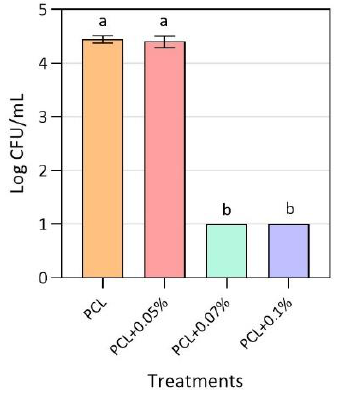
Figure 2. Antibacterial activity of neat polycaprolactone (PCL) films and active PCL films with different CuONPs concentrations against MRSA. The detection limit was 10 CFU/mL. Mean values with different letters represent significant differences ( p < 0.05) among the samples, as determined with a one-way analysis of variance (ANOVA) and Tukey’s multiple comparison tests.